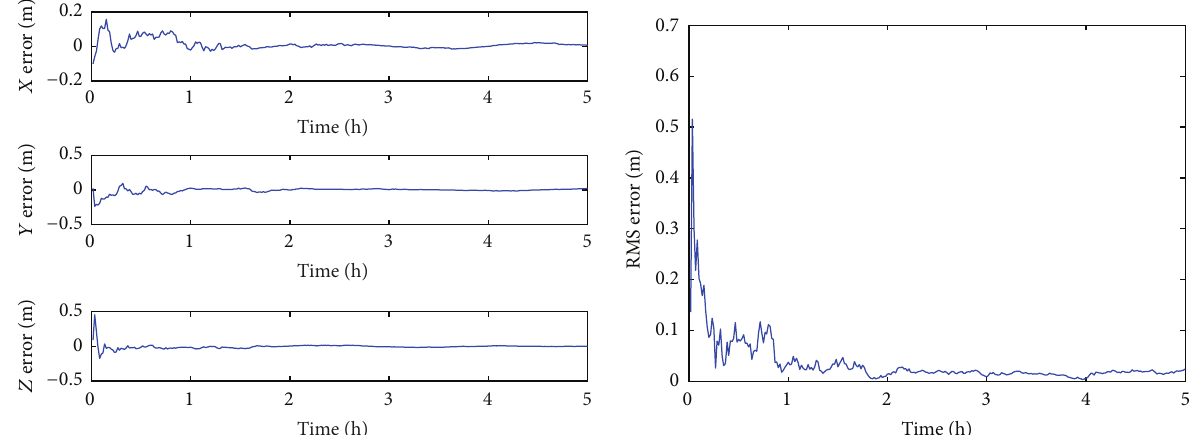
Figure 12: Error of absolute position estimation for satellite 3 using